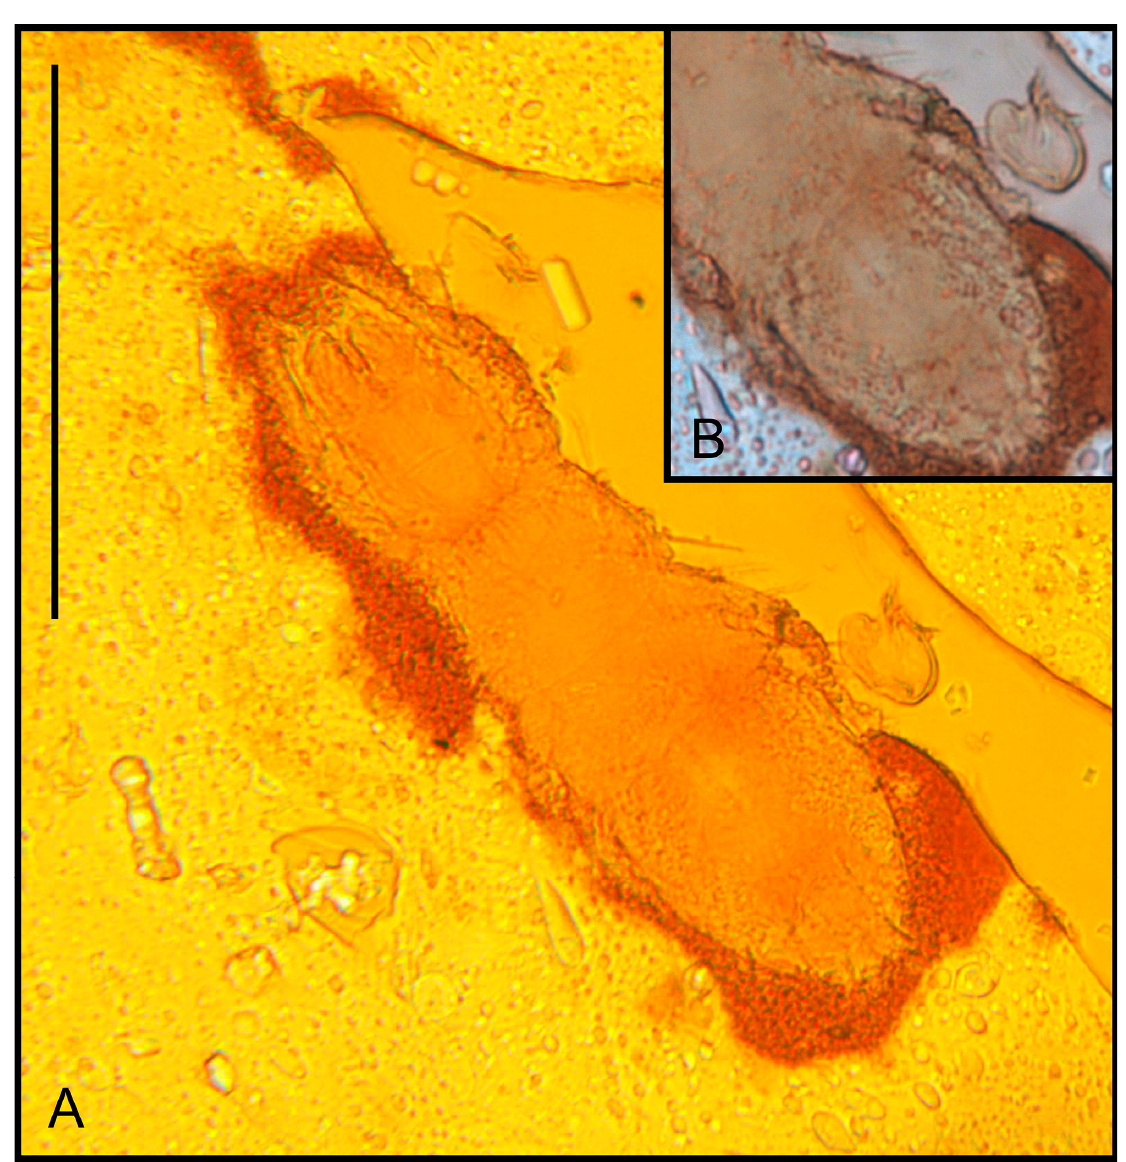
Figure 16. Paralycus pyrigerus (Berlese, 1905), holotype, light microscope images: ( A )—dorsal view; ( B )—ventral view (inset). Scale bar 100 µm.